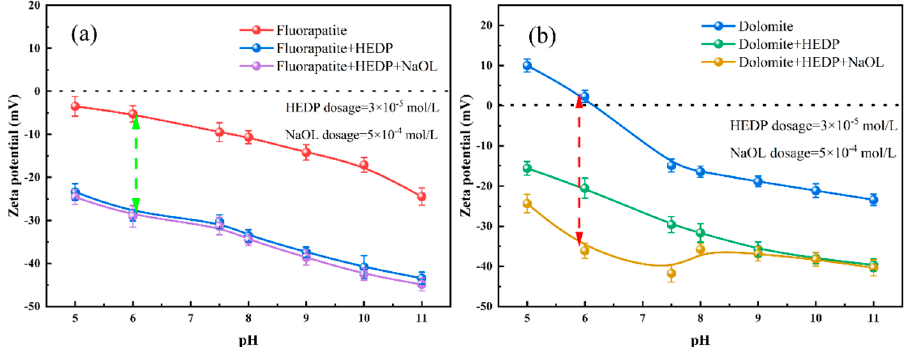
Figure 8. Zeta potentials of fluorapatite ( a ) and dolomite ( b ) treated with HEDP and NaOL at vary- ing pH values (HEDP:3 × 10 − 5 mol/L; NaOL:5 × 10 − 4 mol/L). red line: Zeta potential decline of fluo- rapatite under different conditions; Green line: Zeta potential decline of dolomite under different conditions